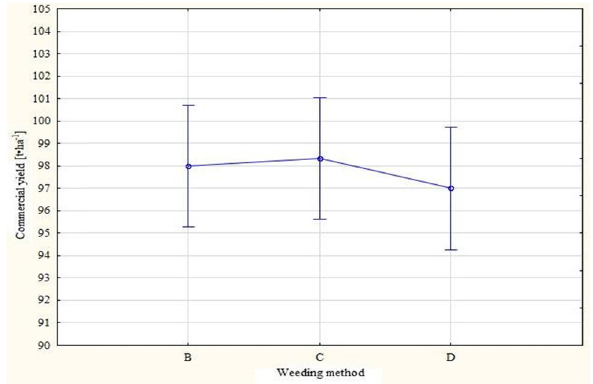
Figure 10: The expected marginal averages for 0.95 con fi dence intervals for commercial yield according to the various methods of weeding carrots in 2017 ( source: own work ) .